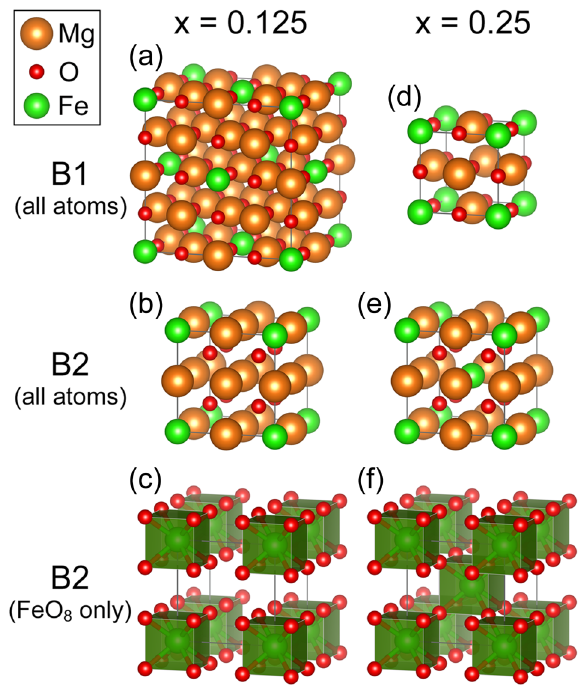
Fig. 1 Supercells of B1 and B2 (Mg 1 − x Fe x )O. For x = 0.125 ( a – c ) and x = 0.25 ( d – f ), 16- and 8-atom supercells are adopted, respectively. For the B2 phase, FeO 8 polyhedra are also plotted ( c , f ). In B2 (Mg 0.75 Fe 0.25 )O, a 3D network of corner-sharing FeO 8 cubes is formed ( f ).